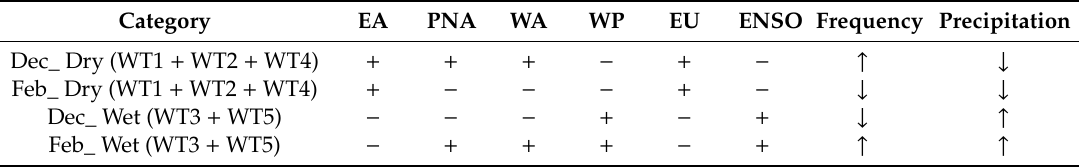
Table 1. The links to the various teleconnection phases (positive or negative), the variation of frequencies of di ff erent WTs (Dry and Wet), and the correlation to higher or lower amounts of precipitation. The bold font marks types that play leading roles. EA: eastern Atlantic pattern, PNA: Pacific / North American pattern, WA: western Atlantic pattern, WP: western Pacific pattern, and EU: Eurasian pattern, ENSO: El Niño–Southern